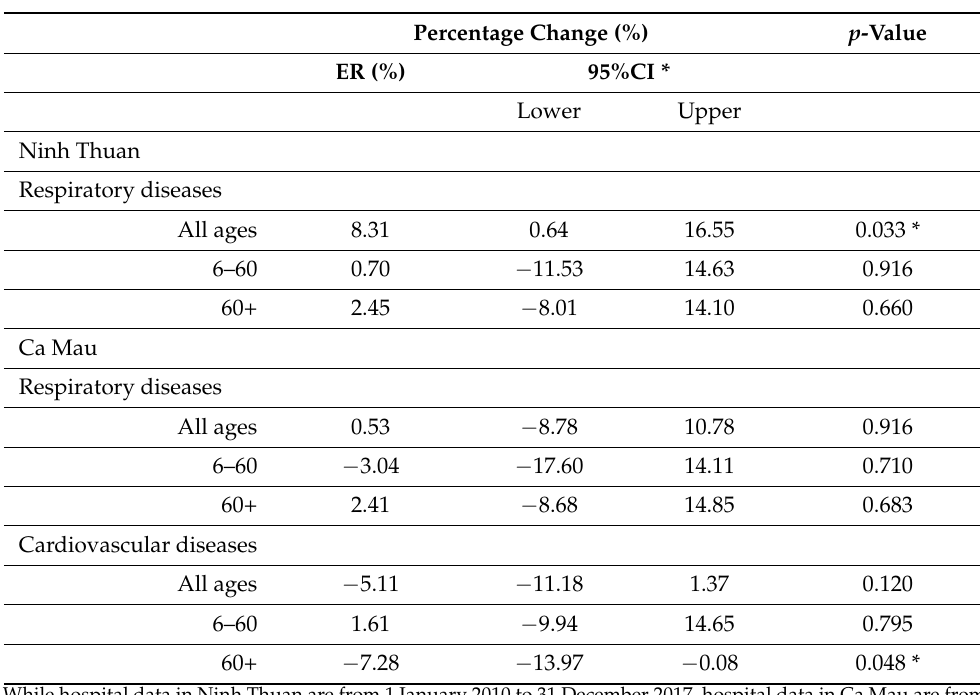
Table 3. Associations between heatwaves and hospital admissions for cardiovascular and respiratory diseases in Ninh Thuan and Ca Mau, 2010–2018 at lag 2.